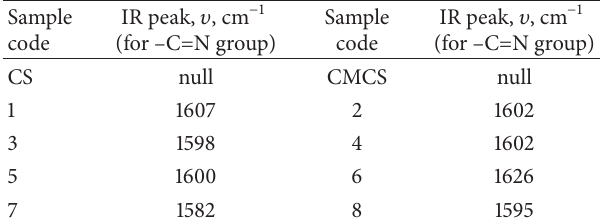
Table 2: FTIR peaks of the imine group for different CS or